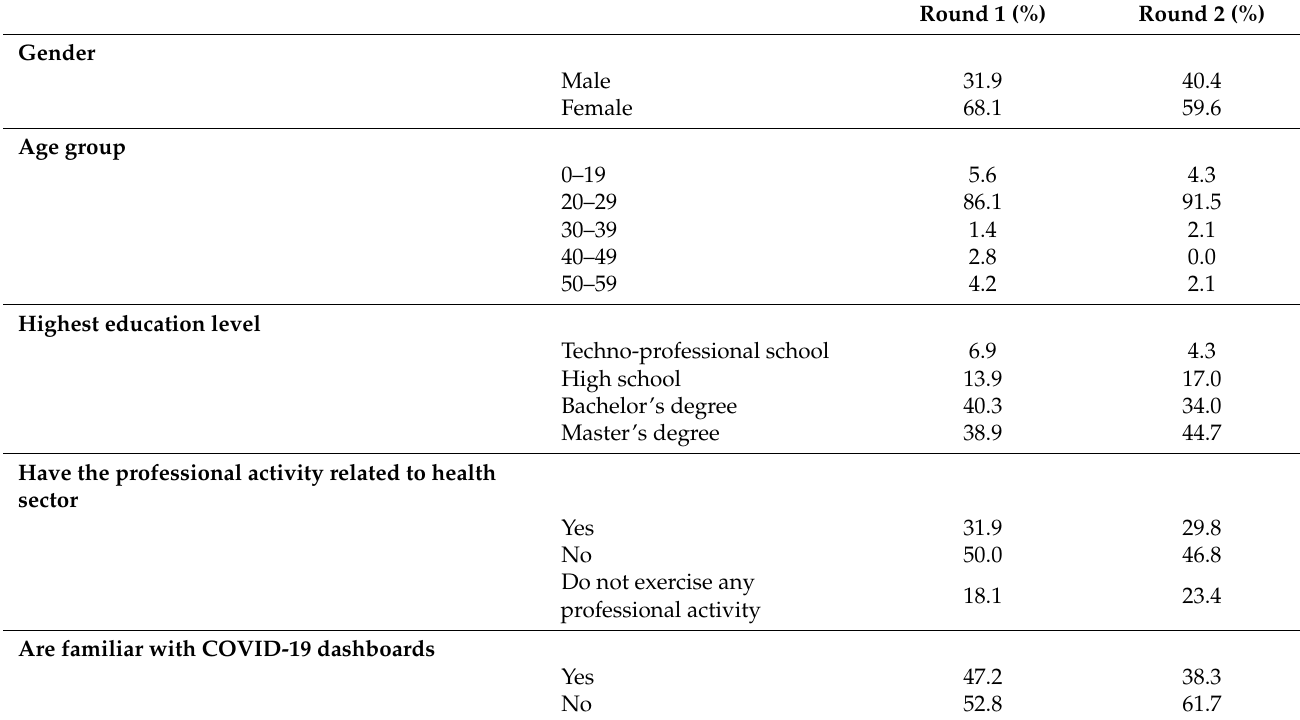
Table 3. Socio-demographic characteristics of first and second rounds’ participants.